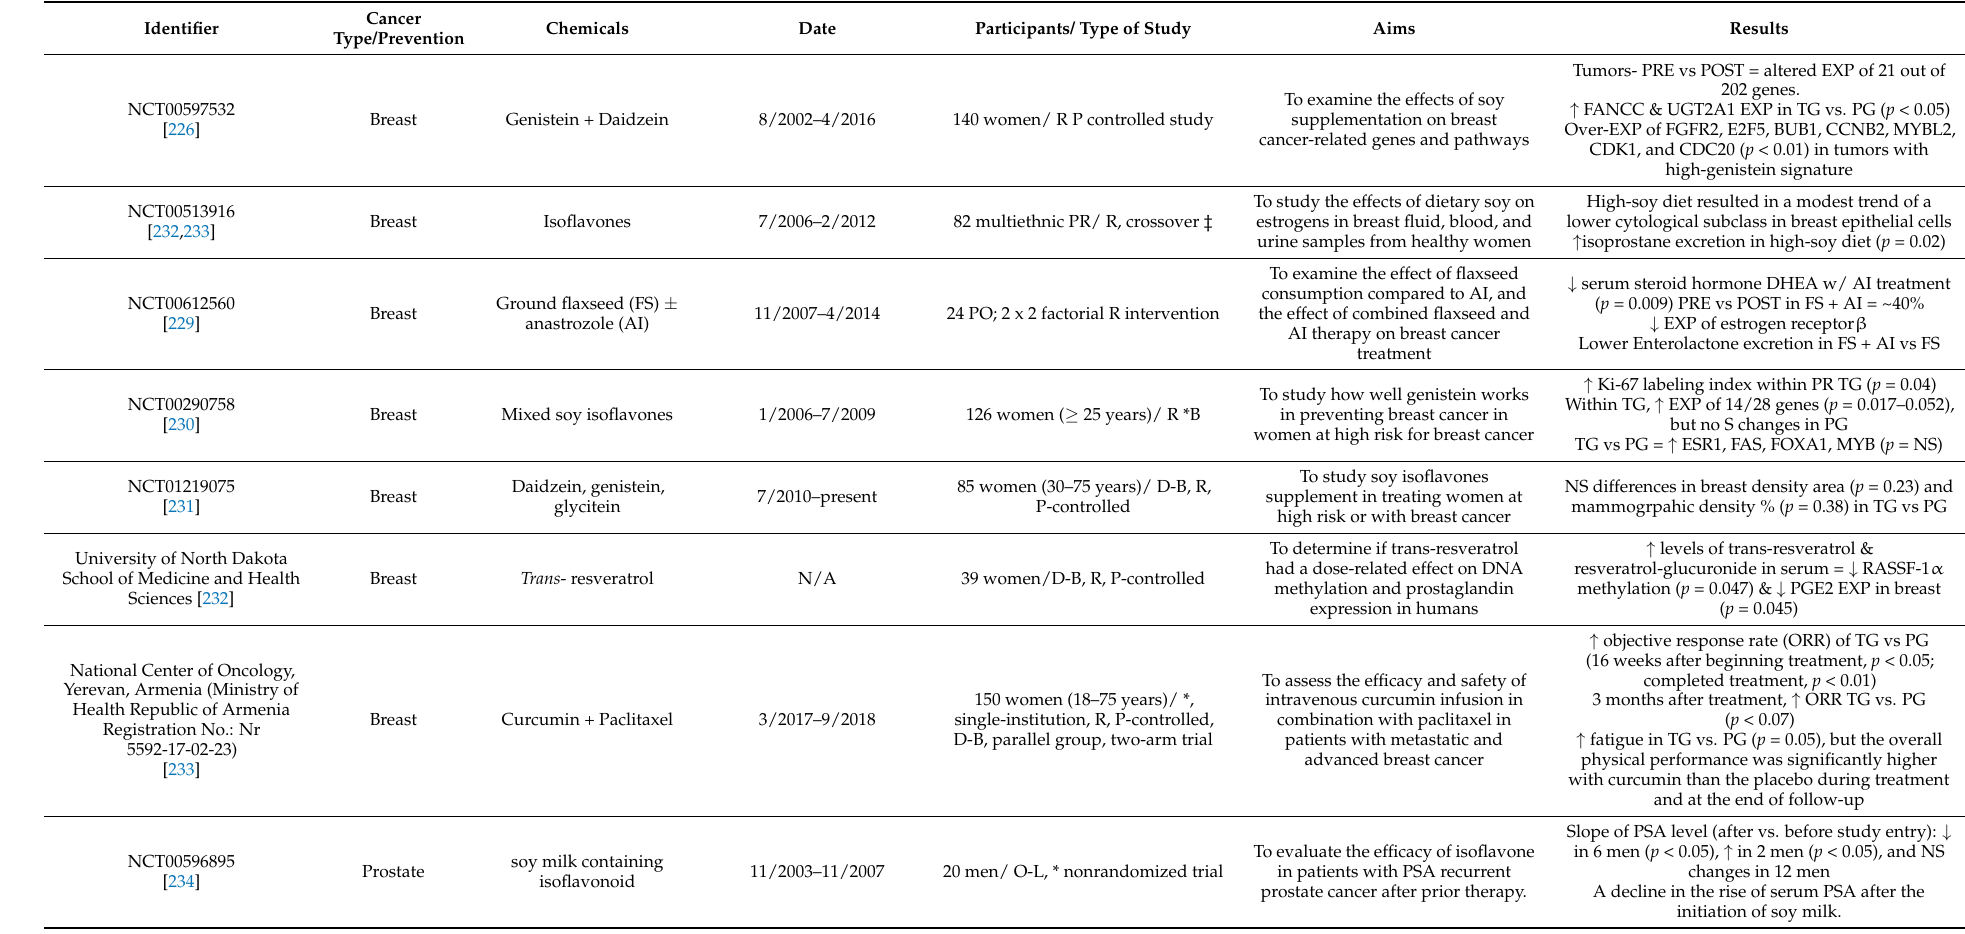
Table 3. Clinical trials of phytoestrogens used as cancer prevention and/or cancer